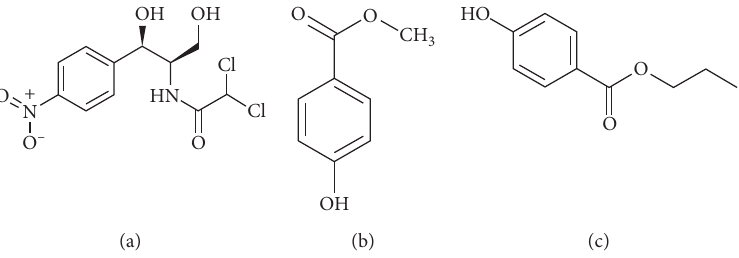
Figure 1: Structural formulas of chloramphenicol (a), methylparaben (b), and propylparaben (c).